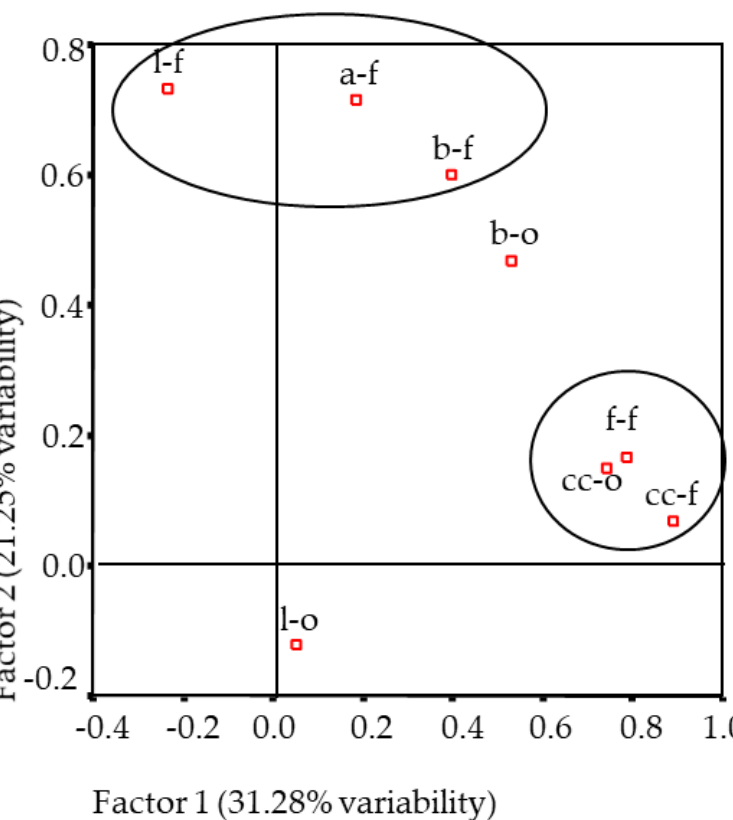
Figure 3. Plot of the the odour and flavour attributes of the Longissimus thoracis muscle from Navarra breed lambs on the bidimensional space formed by factors 1 and 2 (cc-o: characteristic odour; b-o: blood odour; l-o: liver odour; cc-f: characteristic flavour; b-f: blood flavour; l-f: liver flavour; f-f: fatty flavour; a-f: aftertaste).